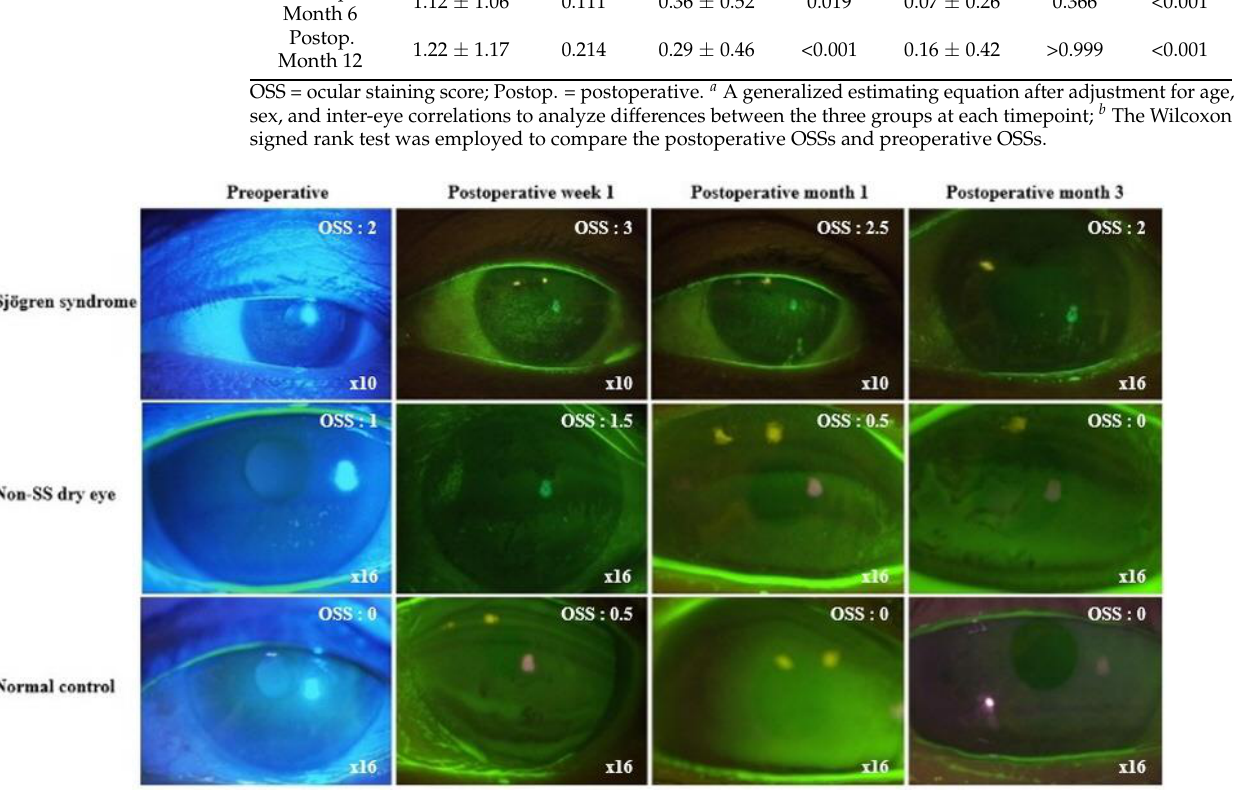
Table 2. Preoperative and Postoperative OSSs.